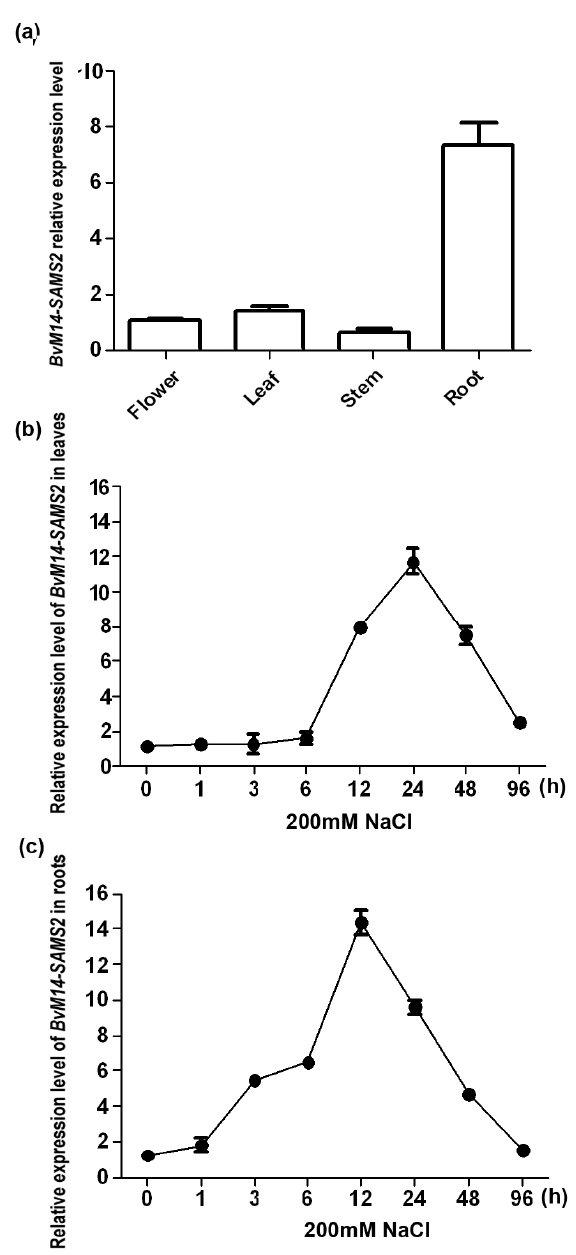
Figure 2. Tissue specific expression of BvM14-SAMS2 gene in the M14 plants and induction of the BvM14-SAMS2 mRNA in response to salt stress. ( a ) Real time-PCR detection of BvM14-SAMS2 gene in different tissues. Time-course analysis of BvM14-SAMS2 relative expression levels in leaves ( b ); and roots ( c ) of the M14 plants under 200 mM NaCl stress. Data for real time-PCR analysis are the